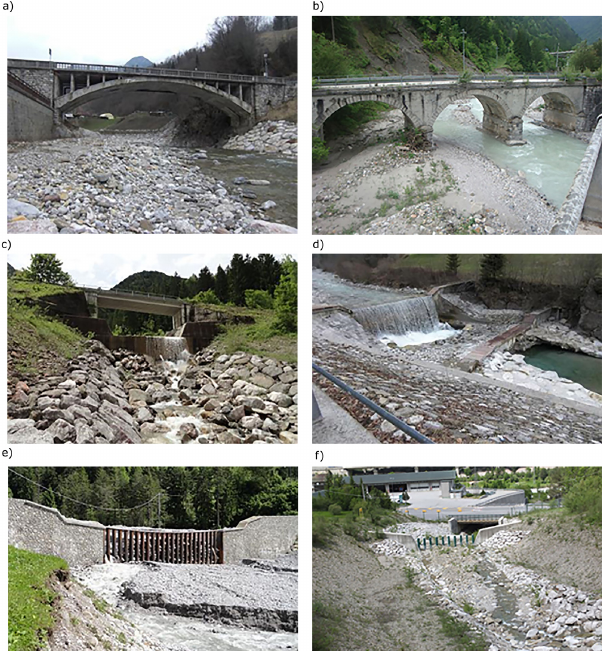
Figure 3. Photo record of the structures inspected: (a) upstream view of bridge 1: pretest and test 1. (b) Upstream view of bridge 2: test 2. (c) Upstream view of bridge 3: test 3. (d) check dam 1: pretest and test 1. (e) Opening of check dam 2: test 2. (f) Upstream to downstream view of check dam 3: test